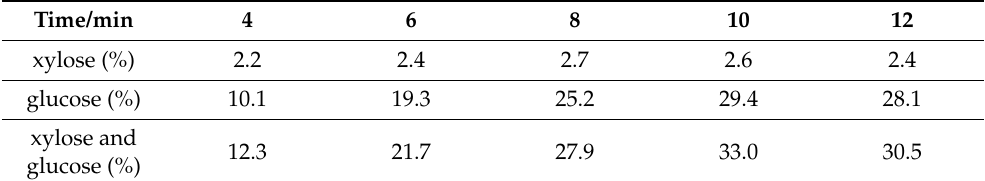
Table 5. Effect of time on xylose and glucose yield in the second step.